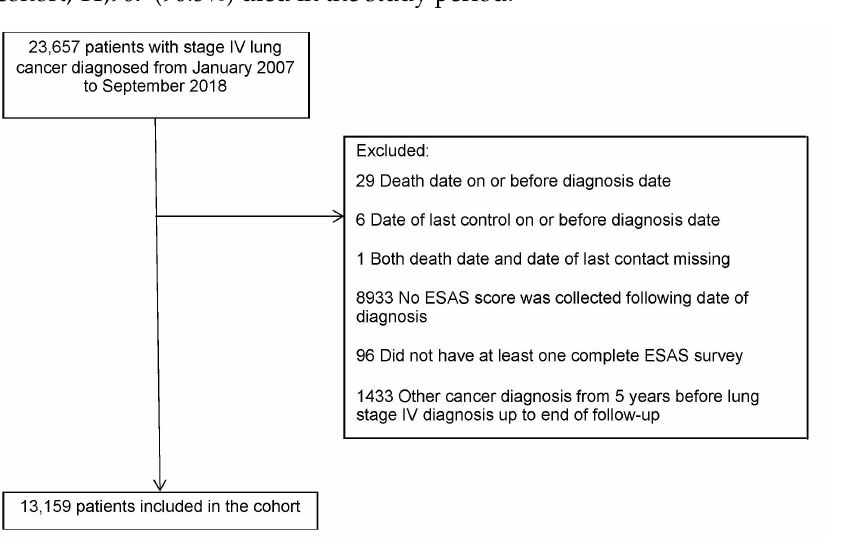
Figure 1. Study cohort.